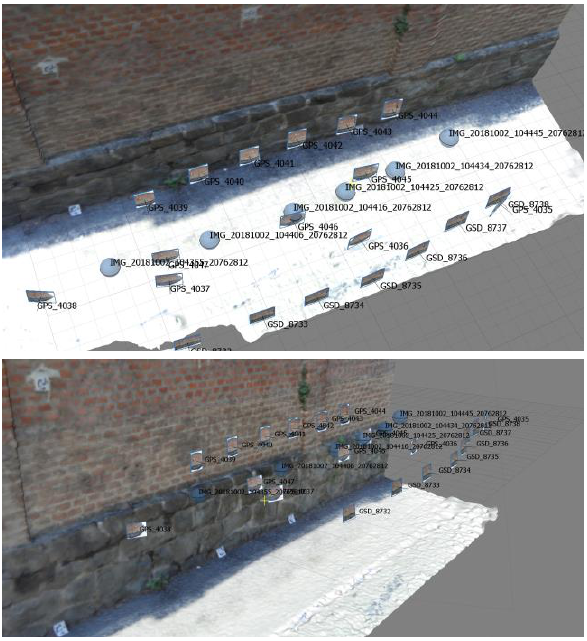
Figure 9. The test where spherical, fisheye and central perspective images were simultaneously